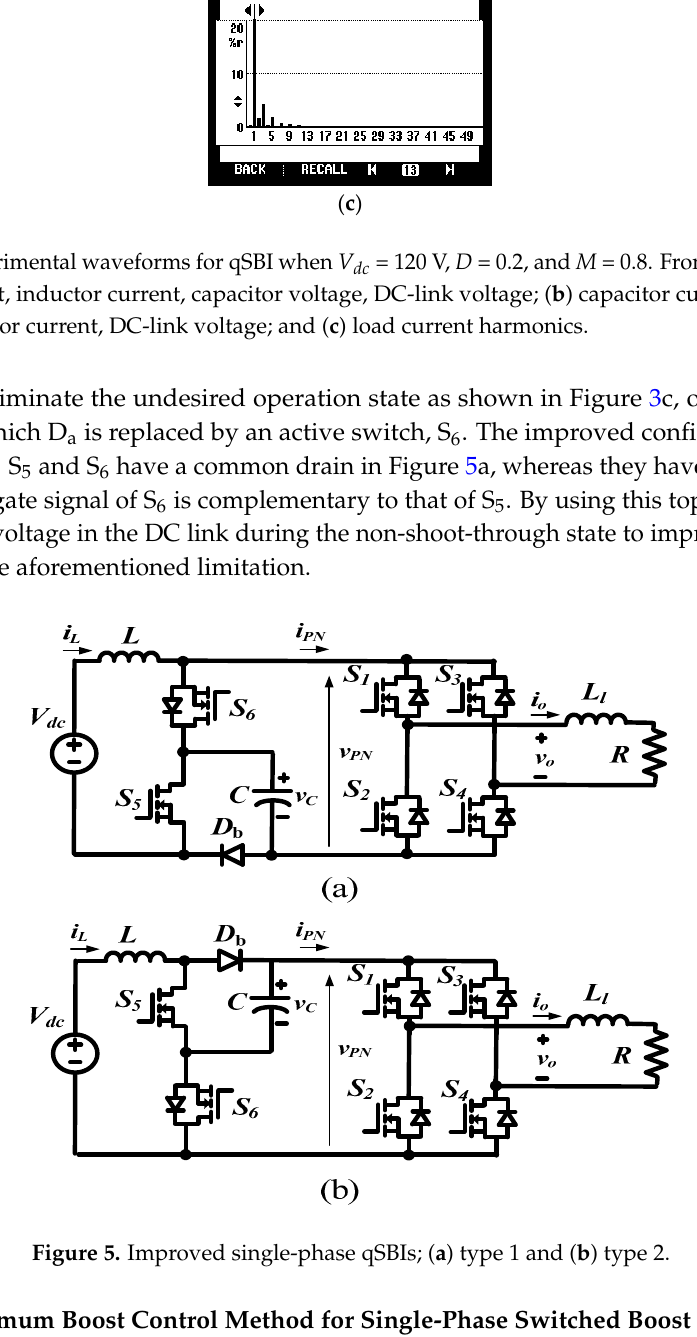
Figure 5. Improved single-phase qSBIs; ( a ) type 1 and ( b ) type 2.